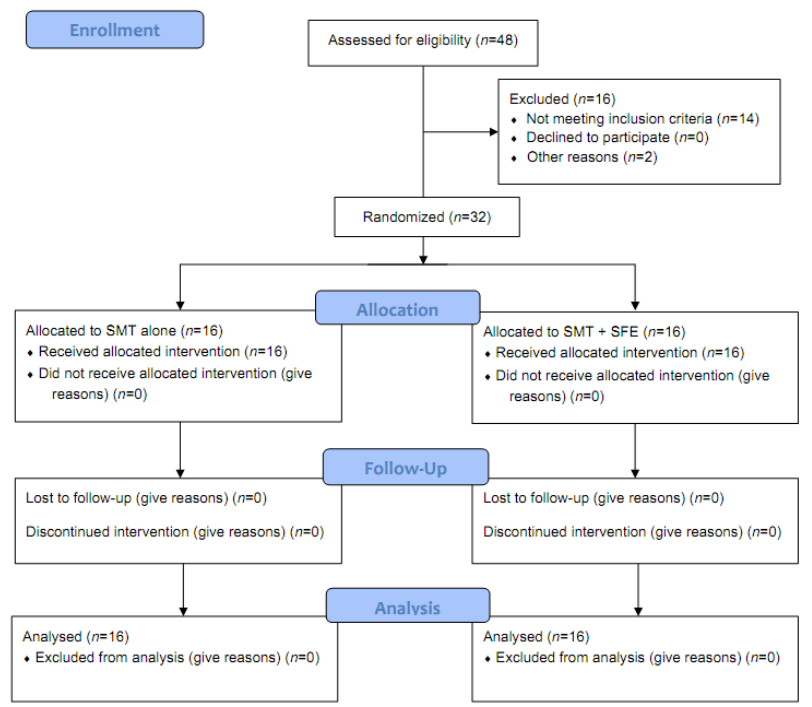
Figure 2. Flow diagram of study.